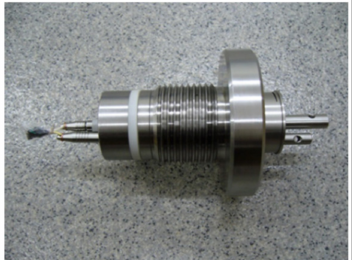
Figure 1. Ignition plug equipped with black powder igniter.